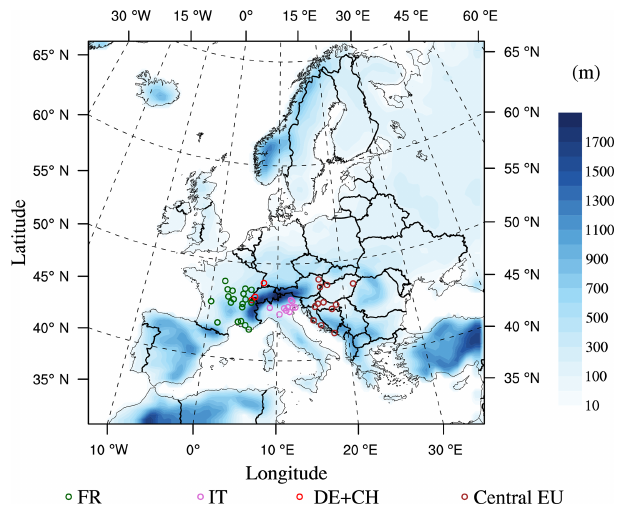
Figure 2. Model domain and the observation sites with